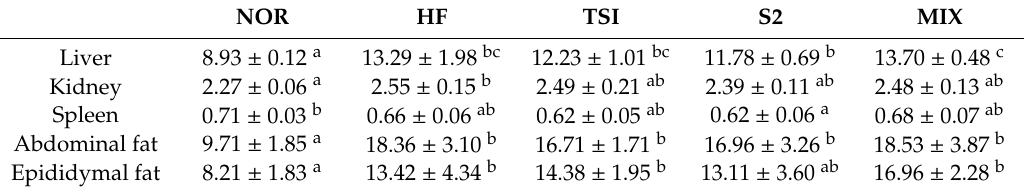
Table 7. Organ weight (g) and fat weight of SD rats fed with experimental diet for 8 weeks ( n =